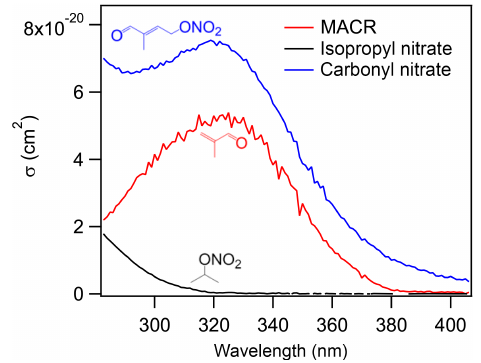
Figure 3. UV absorption cross section of the nitrooxy enal, MACR, and isopropyl nitrate. The spectra were all obtained in acetonitrile solvent.